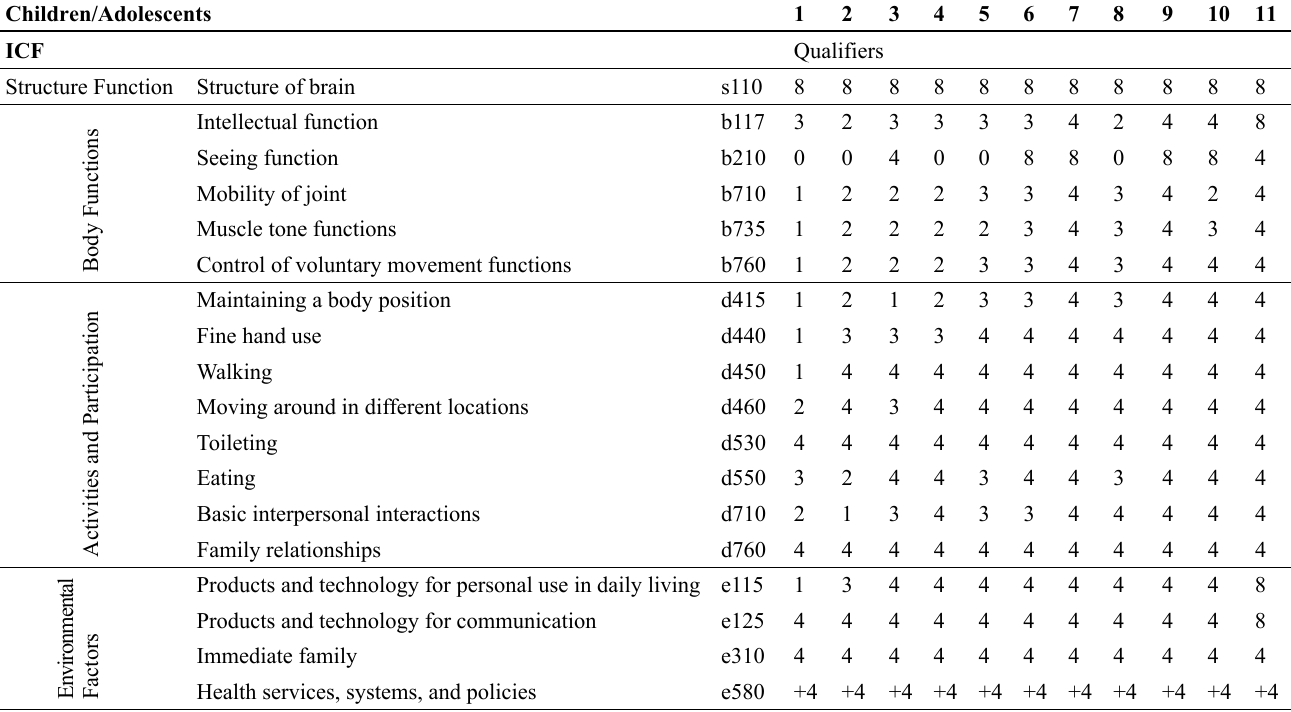
Table 3. ICF of institutionalized children and adolescents with CP